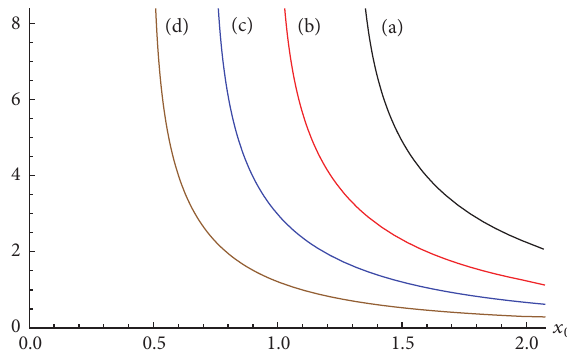
Figure4:Exactperiod 𝑇 in(17)asafunctionoftheinitialamplitude 𝑎 = −1 , 𝑥 > (−3𝑎 /𝑎 ) 1/4 and (a) 𝑎 𝑥 0 when 1 0 1 5 = 10 , and (d) 𝑎 = 50 . 𝑎 5 5